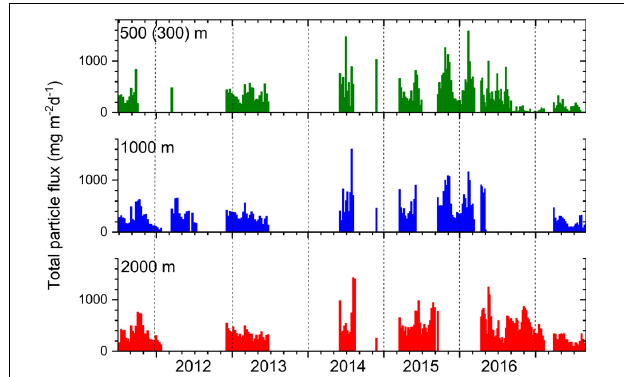
FIGURE 2 | The total particle flux at the three sampling depths from July 2011 to September 2017 (No bar indicates no data).